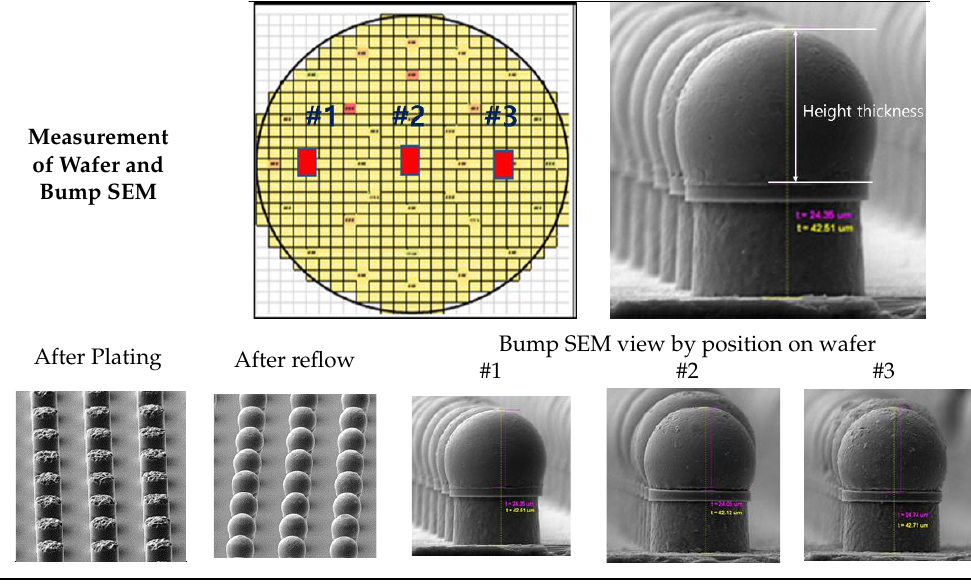
Table 8. Evaluation method, measurement location, and bump shape on wafer.